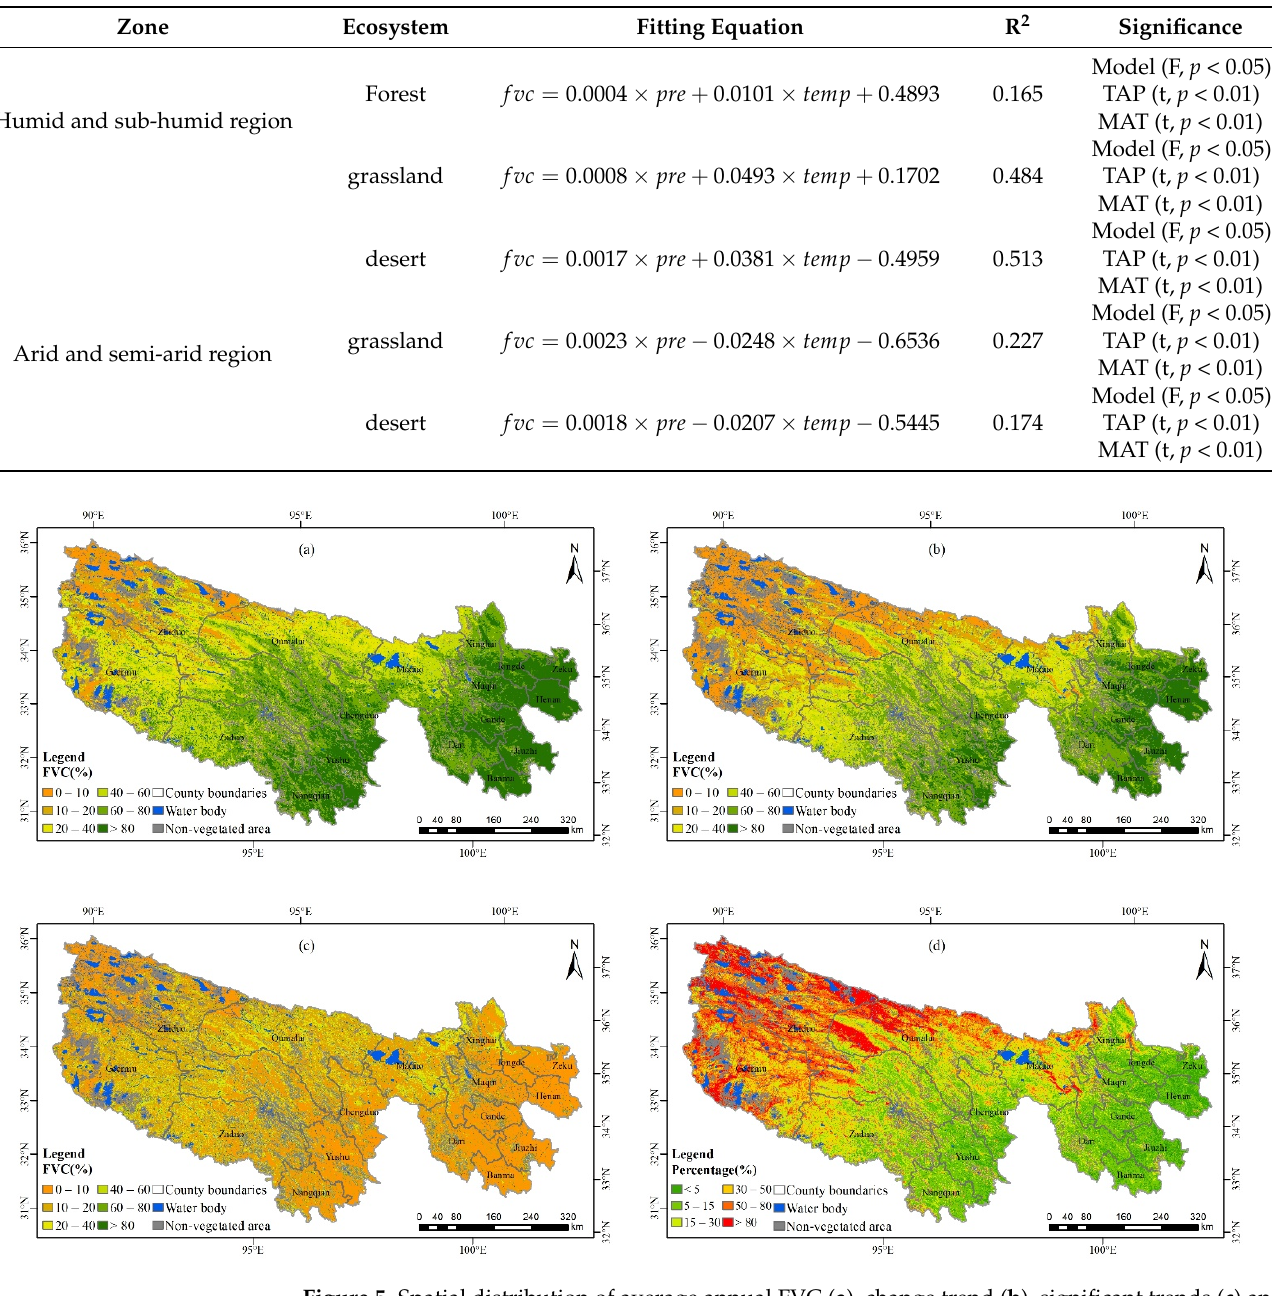
Table 1. The regression equation between FVC and temperature and precipitation in the climax ecological region (CEZ).